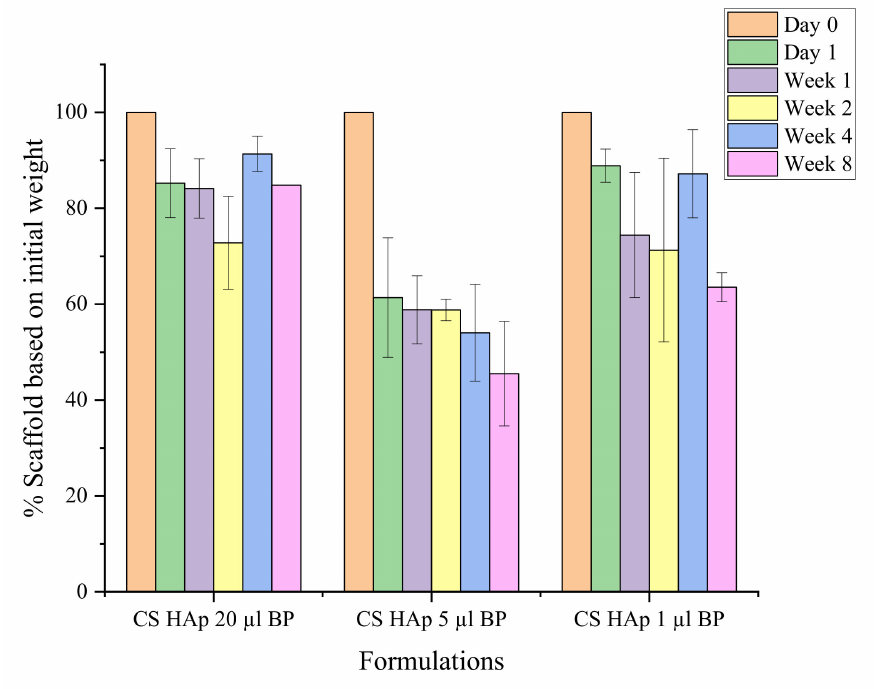
Figure 9. The degradation profile of CS/HAp scaffolds with different benzophenone content in SBF, where CS/HAp/5 µ L BP presented a stable degradation rate for eight